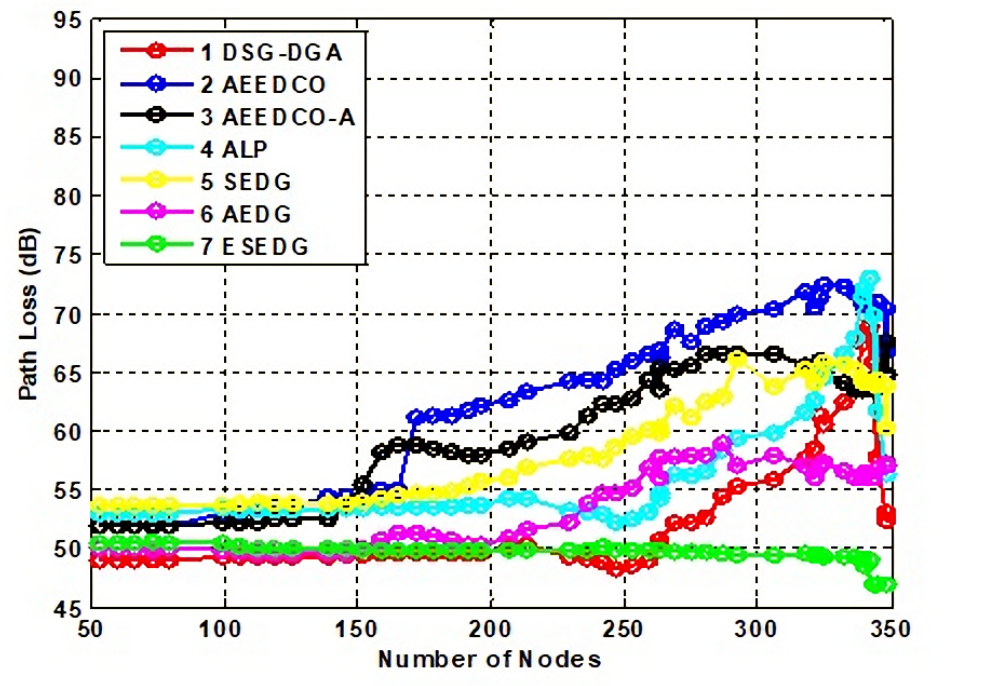
Figure 6. Analysis of path loss with baseline schemes.